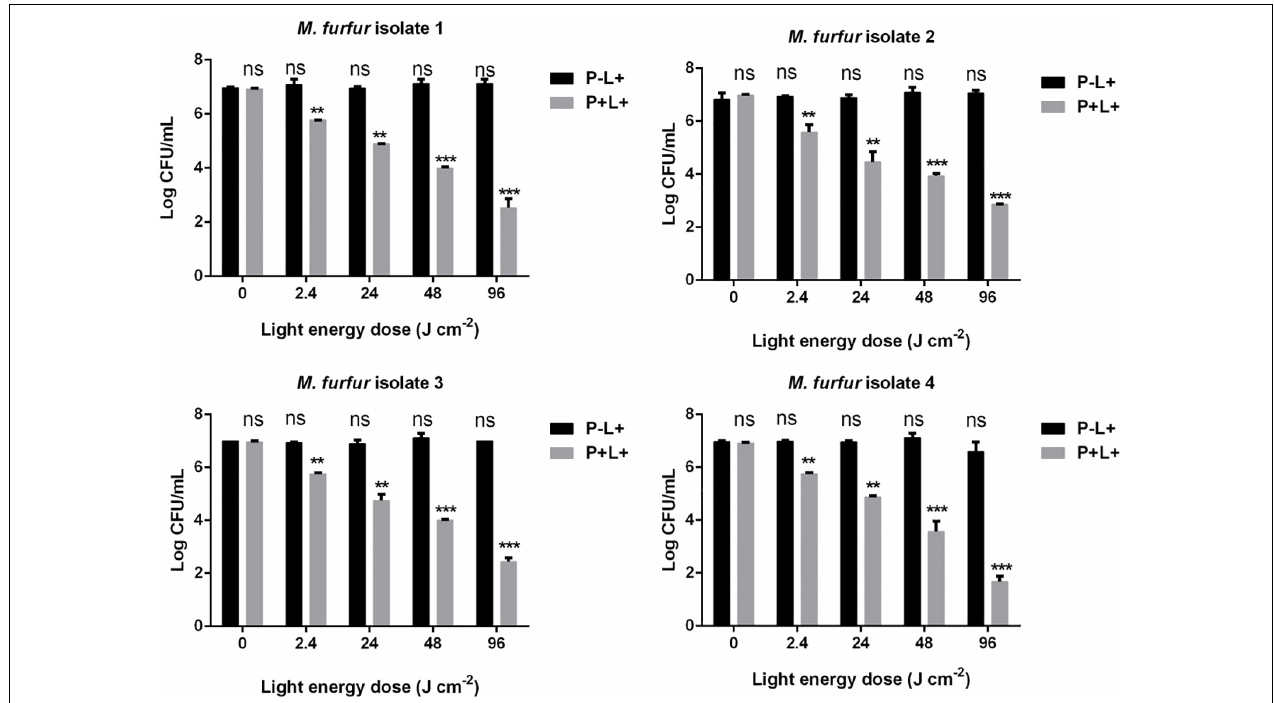
FIGURE 3 | . Survival of M. furfur clinical isolates after aPDT mediated by HMME. (P–L+) represents the M. furfur cells irradiated with different energy doses of light; (P+L+) represents the M. furfur cells treated with 10 µ M of HMME and irradiated with different energy doses of light. Each value refers to mean ± standard deviation (SD; n = 3; ns: no significance, ** P < 0.01, *** P <